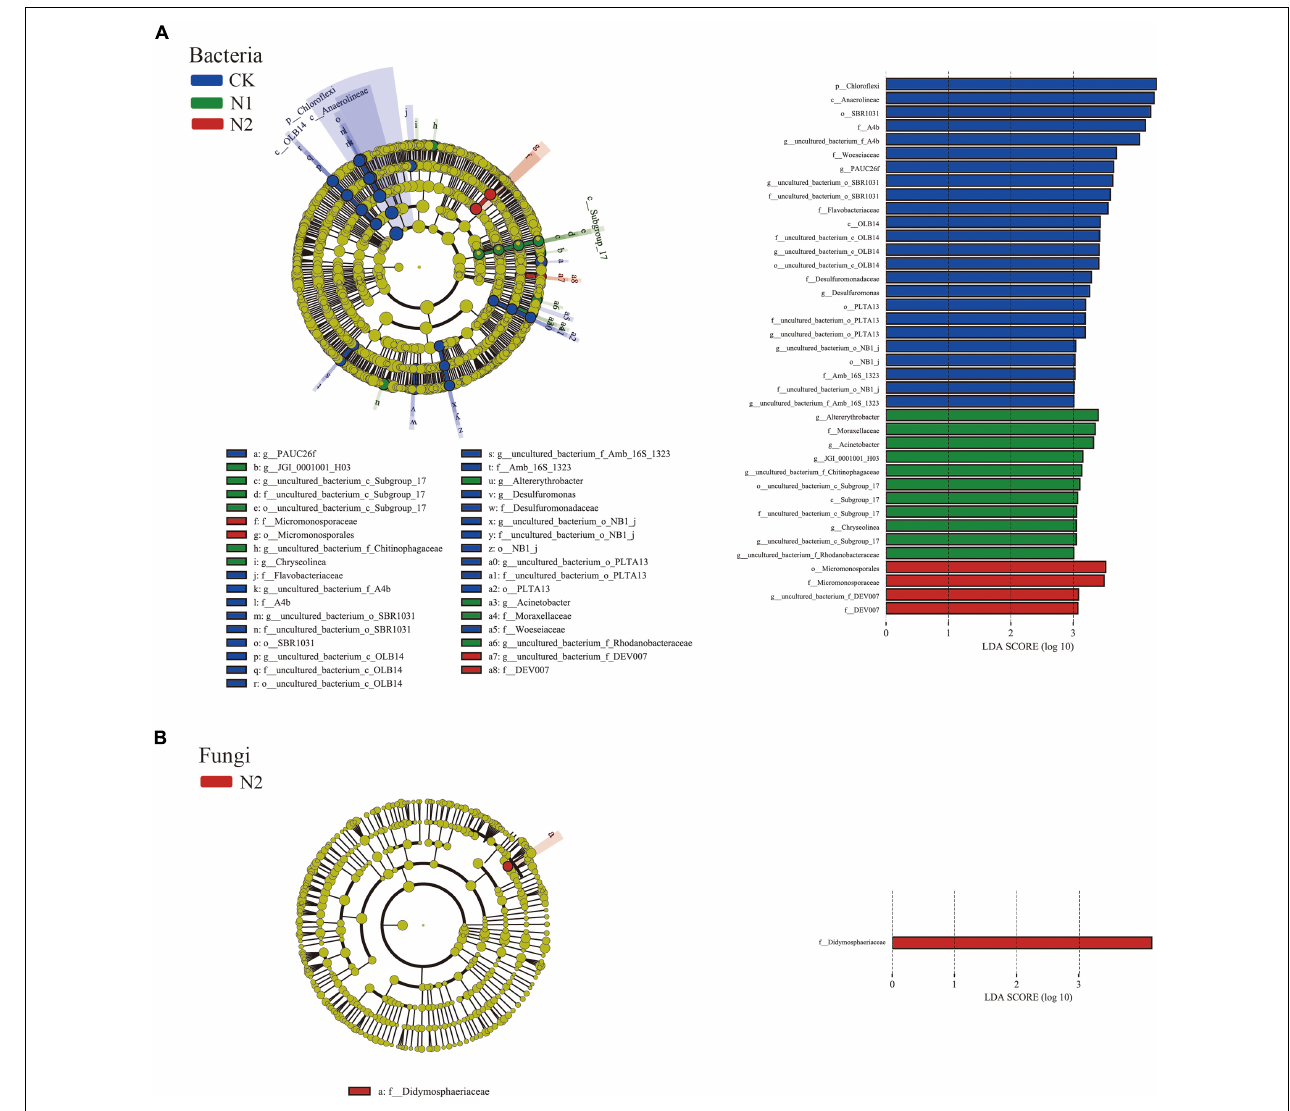
FIGURE 4 | LEfSe analysis of soil microbial community structure after N application (phylum–genus level). (A) Bacterial LEfSe (LDA = 3.0). (B) Fungal LEfSe (LDA = 3.0).